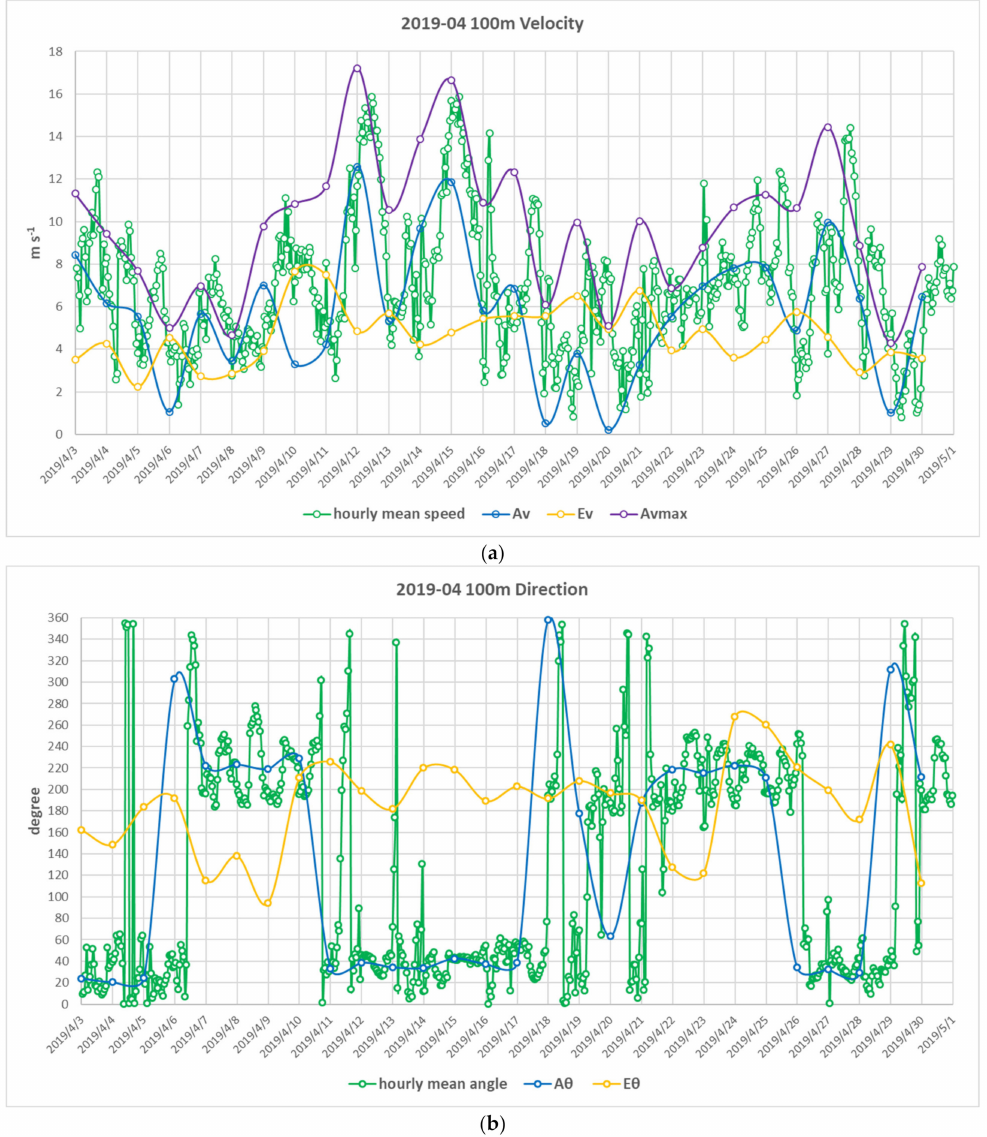
Figure 13. ( a ) Wind speed variation in April 2019 ( b ) Wind direction variation in April 2019. The green line is for the hourly mean wind vector. The blue line is for vector A. The yellow line is for vector E. The purple line is for the possible maximum wind vector of the